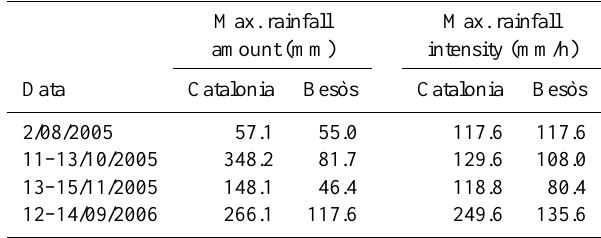
Table 1. Rainfall amount and intensity for the four study events over the entire domain of Catalonia and over the Bes`os